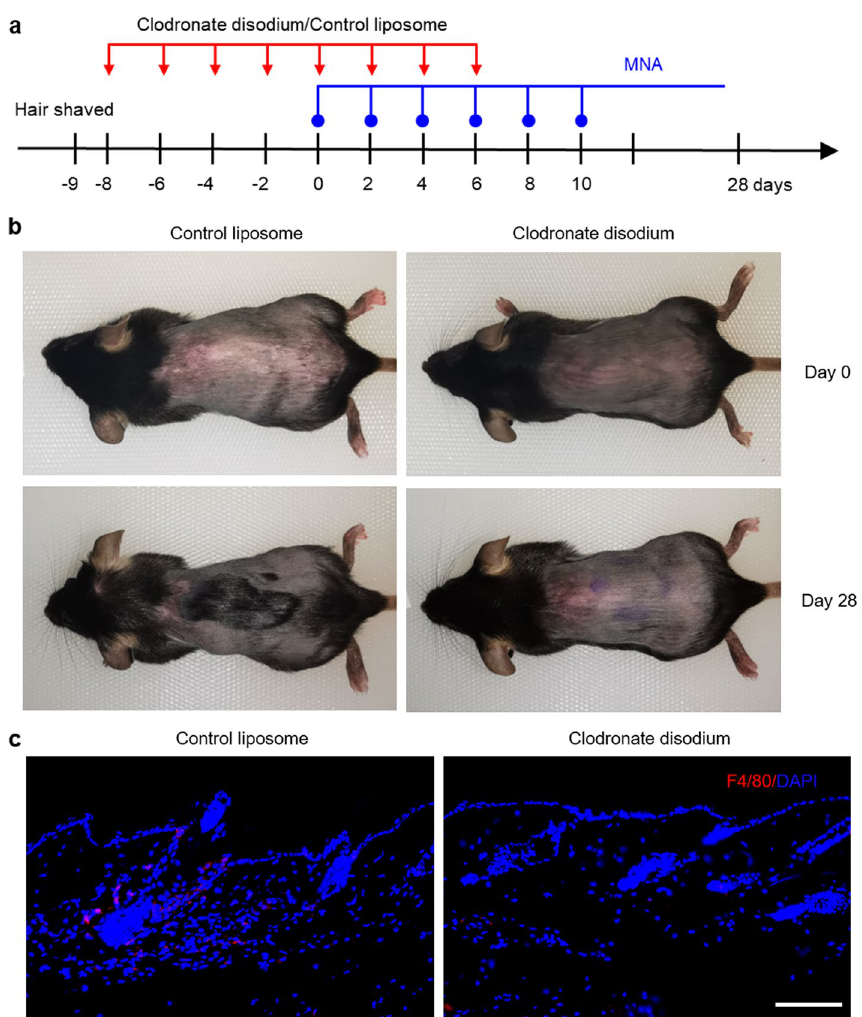
Fig. 7 Abrogated MNA-induced hair regeneration after macrophage depletion. a Schematic diagram of animal treatment. b Representative photos of mice on day 28 showed that MNA-induced hair regeneration was impeded by intraperitoneal injection of clodronate disodium liposomes. c F4/80 immunofluorescence staining showed that MNA-induced macrophage recruitment was hindered after MNA treatment by intraperitoneal injection of clodronate disodium liposomes. (Scale bar: 100